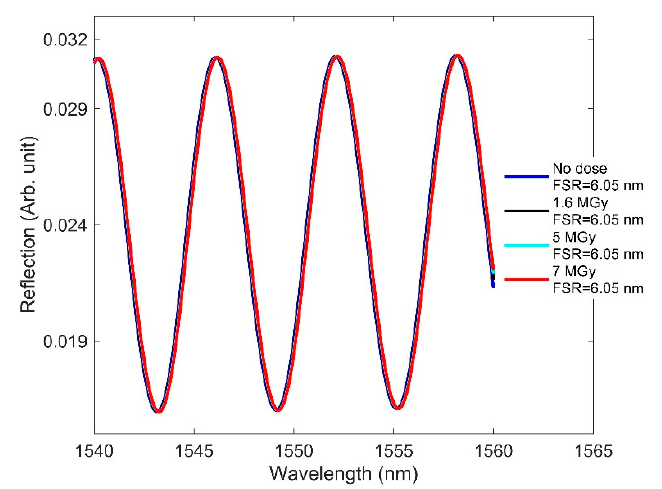
Figure 14. RIC effects on the interferometric fringes of the designed F-P sensor at high doses.